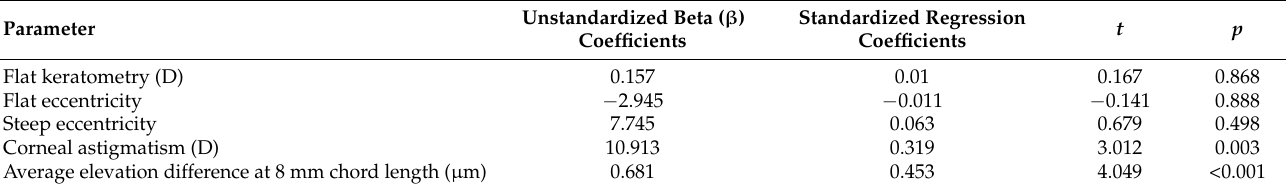
Table 3. Association between toricity of lens and corneal Table 2. Correlation of lens toricity with baseline ocular biometrics using Spearman’s correlation analysis.